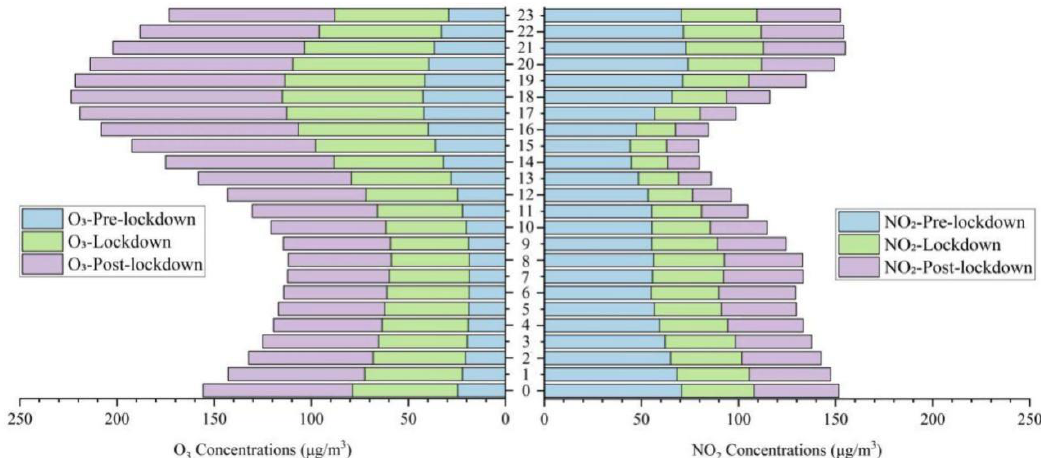
Figure 10. Hourly variations of O 3 and NO 2 concentrations during the preset periods.